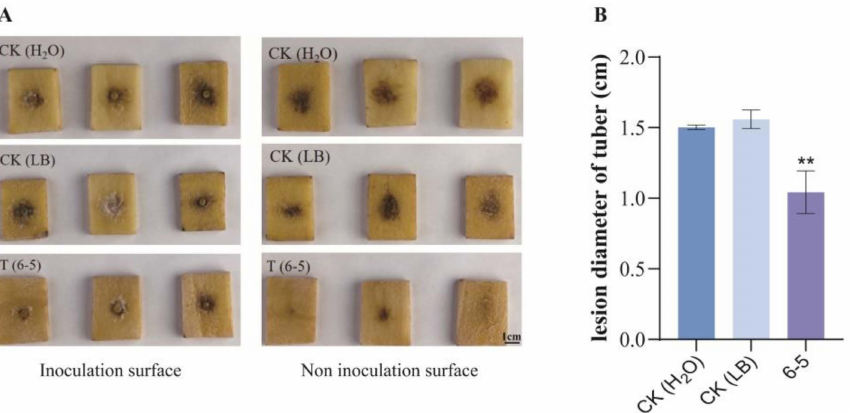
Figure 4. Effect of 6-5 on the resistance of potato tubers to late blight. ( A ) The disease symptom of potato tuber slices pretreated with 6-5 bacterial suspension; ( B ) the lesion diameter of potato tuber slices. ** p <